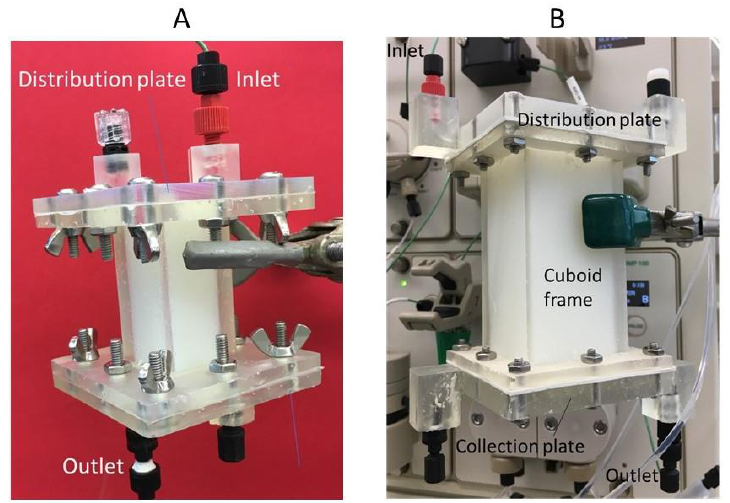
Figure 3. ( A ) Photograph of the 24 mL z 2 cuboid SEC device used in this study. ( B ) Photograph of the 200 mL z 2 cuboid SEC device used in this study. the 200 mL z 2 cuboid SEC device used in this